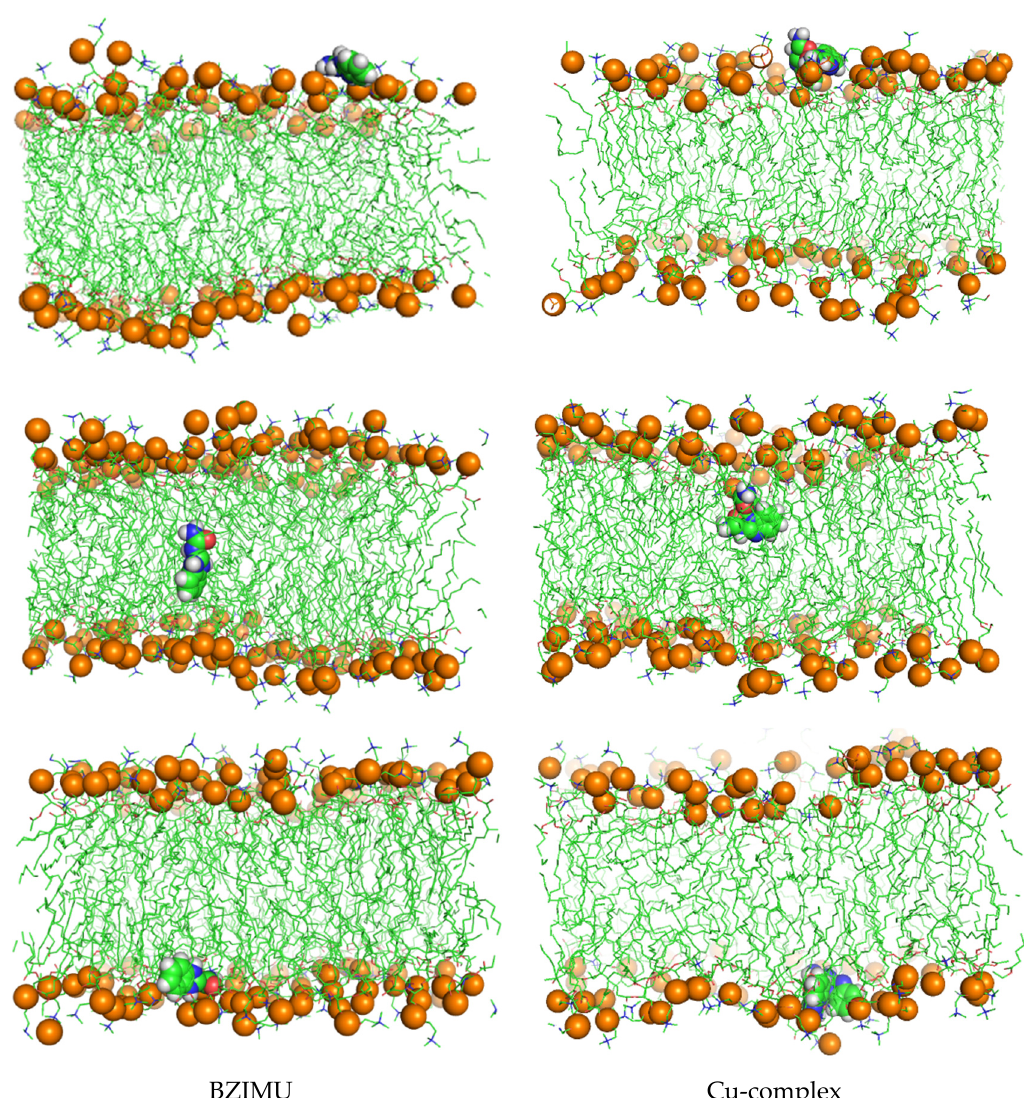
Figure 5. Trajectory of BZIMU and Cu-complex entering the membrane. Snapshots taken at 2, 3, and 4 ns for BZIMU and at 1.5, 1.8, and 3 ns for Cu-complex.